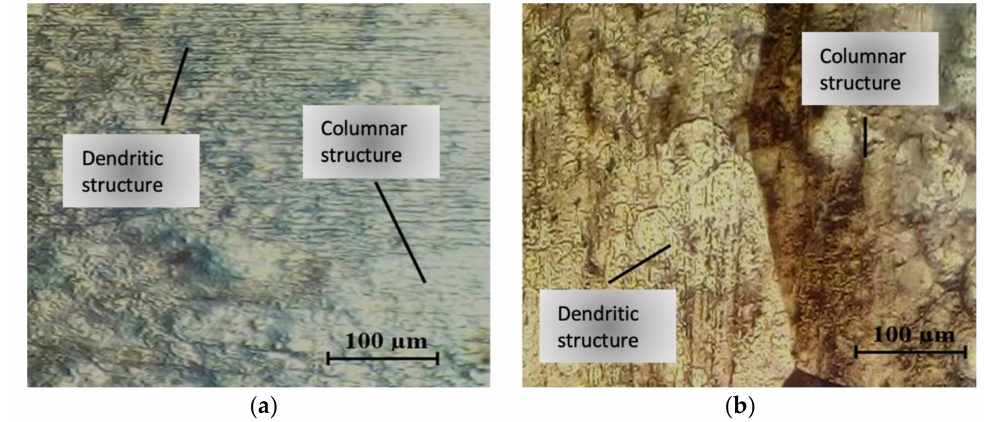
Figure 6. Fusion line micrography; ( a ) left side; ( b ) right